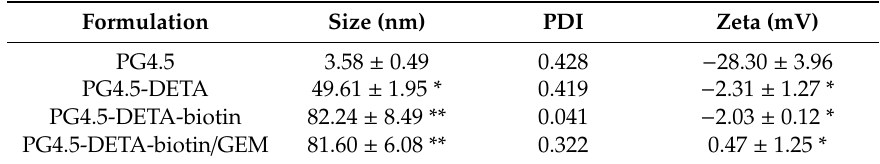
Table 1. Particle size, polydispersity index (PDI), and zeta potentials of PG4.5, PG4.5-DETA,